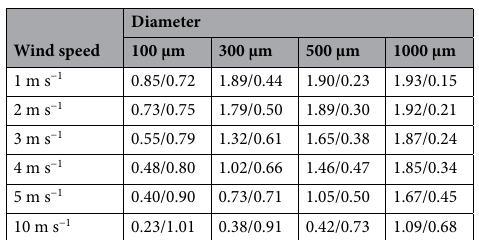
Table 4. Median value and standard deviation of the final position of Microcystis colonies under various constant wind speeds in 24 h. Median value/standard deviation (unit: m).